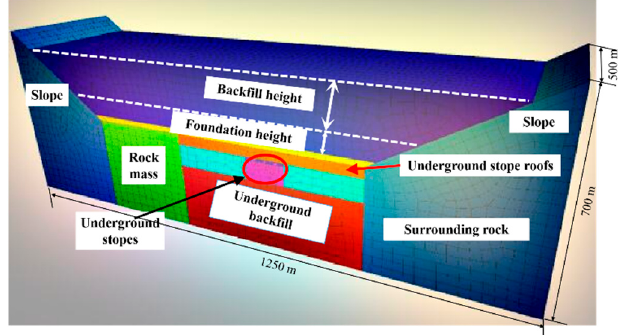
Figure 3. Numerical model.